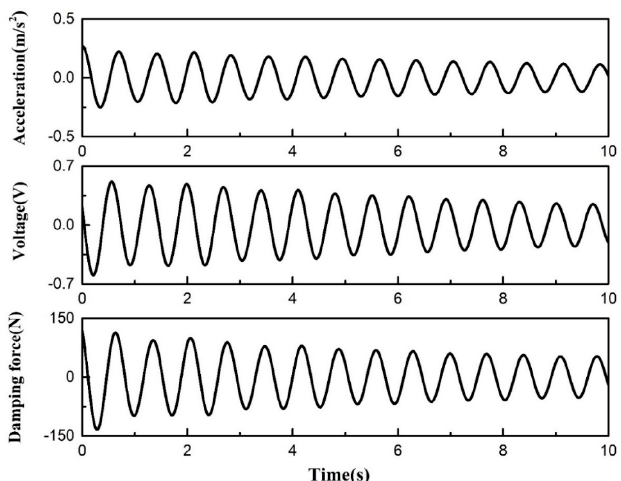
Figure 13. Time histories of acceleration, input voltage, and damping force for the first mode of the cable. Appl. Sci. 2017 , 8 , 118